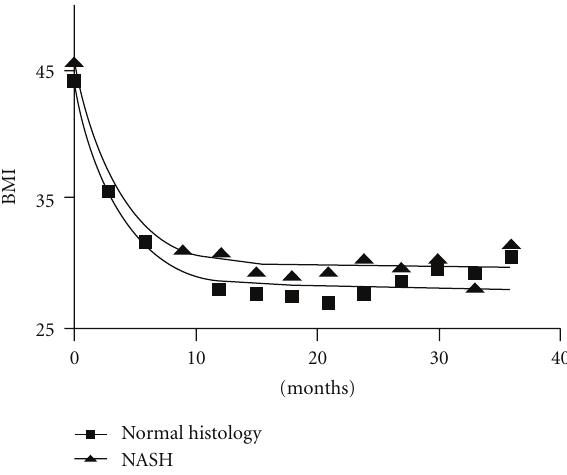
Figure 2: Course of BMI after ISG for patients with normal liver histology versus patients with NASH. Nonlinear regression 95% CI plateau 27.27 to 28.89 kg/m 2 versus 28.69 to 30.89 kg/m 2 , respectively, two-way ANOVA P < . 05.